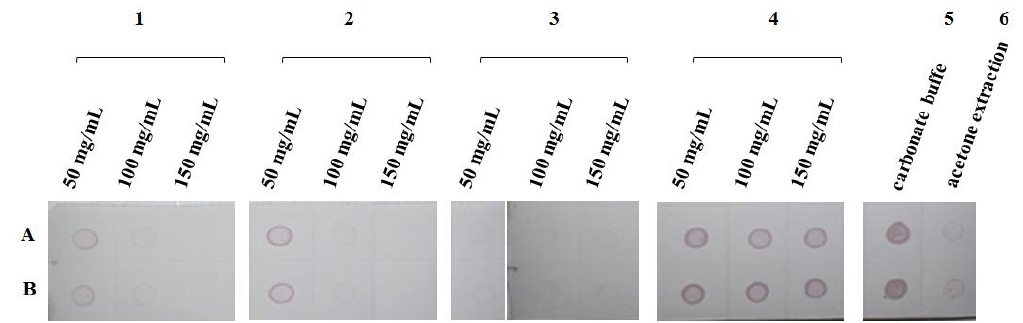
Figure 3. Color of NC membrane after DIBA processing with TBST and 5% non-fat dry milk for blocking as well as antibody and chromogenic detection of alkaline-phosphatase. Numbers 1–4 respectively represent magnesium oxide, alumina oxide, bentonite, and active carbon at 50, 100, and 150 mg/mL, respectively. Number 5 represents the rice extract in carbonate buffer, and number 6 represents the rice extract in buffer after acetone precipitation. Letters A and B represent two repeated samples. The rice infected by the SRBSDV was from the rice sample cultivated in the